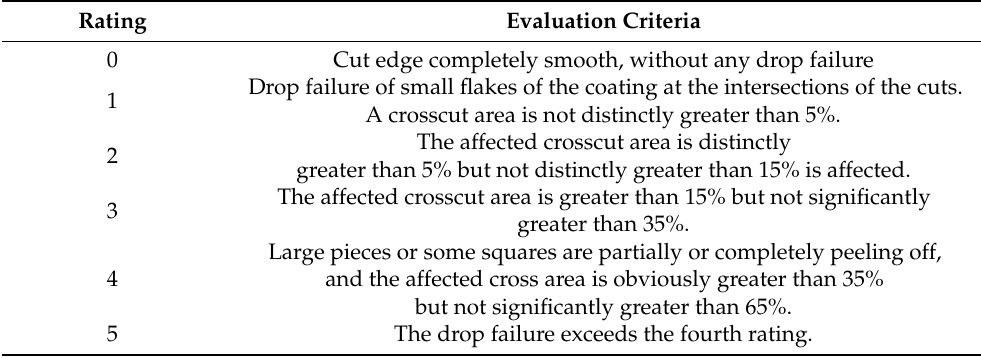
Table 2. Evaluation criteria of coating adhesion